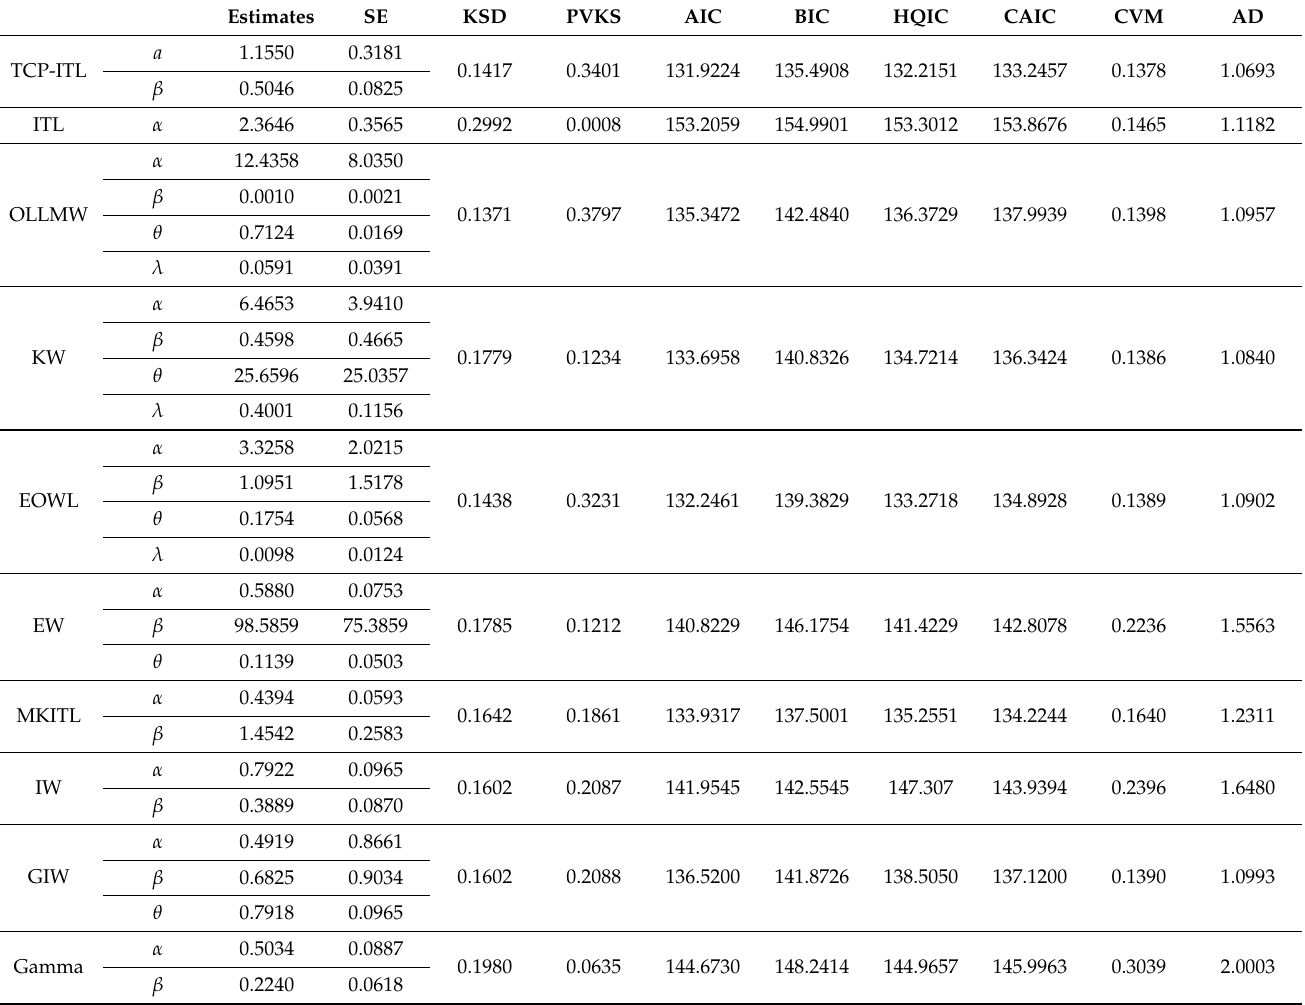
Table 9. MLE and different measures for each model of Data set I Global Reserves Natural.